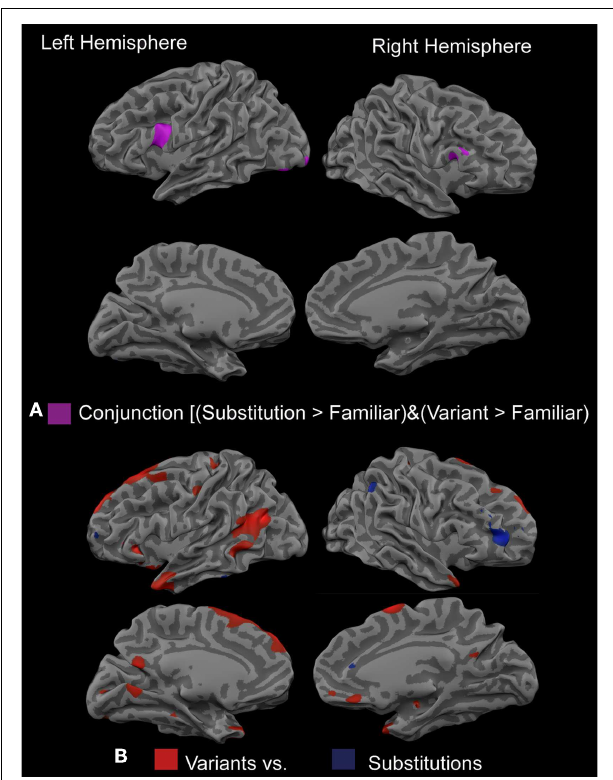
FIGURE 3 | Effect of defamiliarization. (A) Conjunction analysis [(proverb-substitutions > familiar proverbs) and (proverb-variants > familiar proverbs) activated bilateral IFG (LH: BA44; RH: BA9) and bilateral inferior occipital gyrus (IOG; BA18/19). (B) Contrast proverb-variants – proverb- substitutions: Proverb-variants recruited bilateral temporal poles (BA 38), medial prefrontal area (subcallosal ACC, vmPFC, dmPFC), posterior cingulate region (PCC/cuneus), parahippocampal gyri, bilateral occipital cortex, bilateral IFG (BA 47), and left MTG/STG. Proverb-substitutions activated the dorsal part of the ACC, right dlPFC (BA 10), left vlPFC, right IPL (BA40), and left fusiform